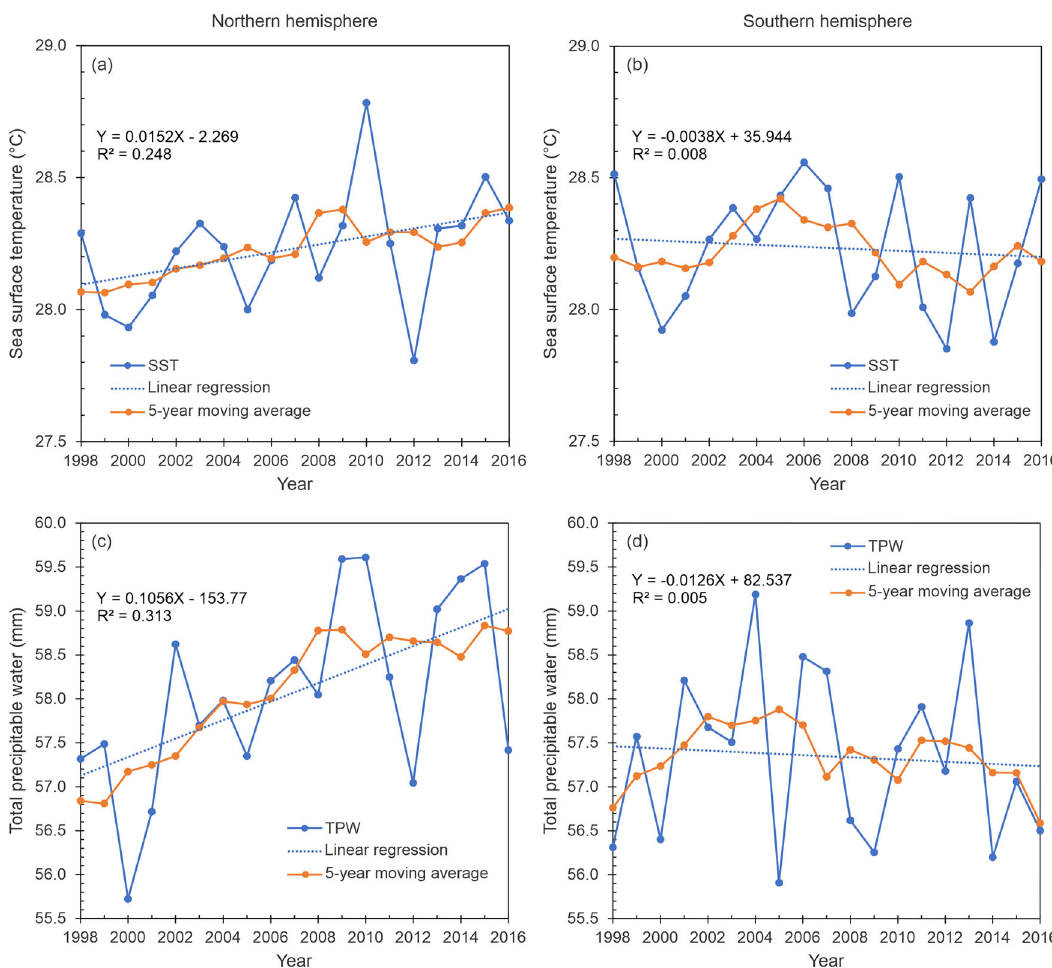
Fig. 4 Time series and the linear regression fi t of TC environmental parameters from 0 to 500 km. a Sea surface temperature in the northern hemisphere, b sea surface temperature in the southern hemisphere, c total precipitable water in the northern hemisphere, and d total precipitable water from in the southern hemisphere. The linear fi tting function and square of the correlation are indicated. The 5-year moving average is also shown.